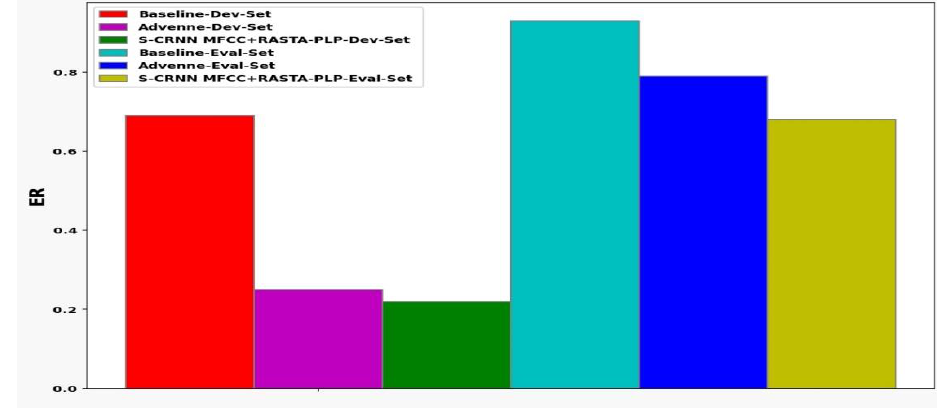
Figure 11. Overall ER comparison using S-CRNN Classifier .